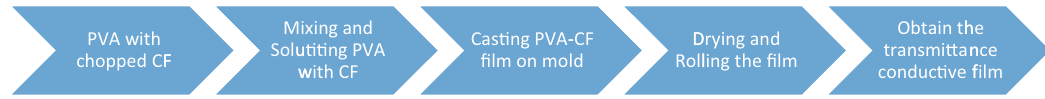
Figure 5: Industrial process of fabricating PVA with CF transparent conductive fi lm.